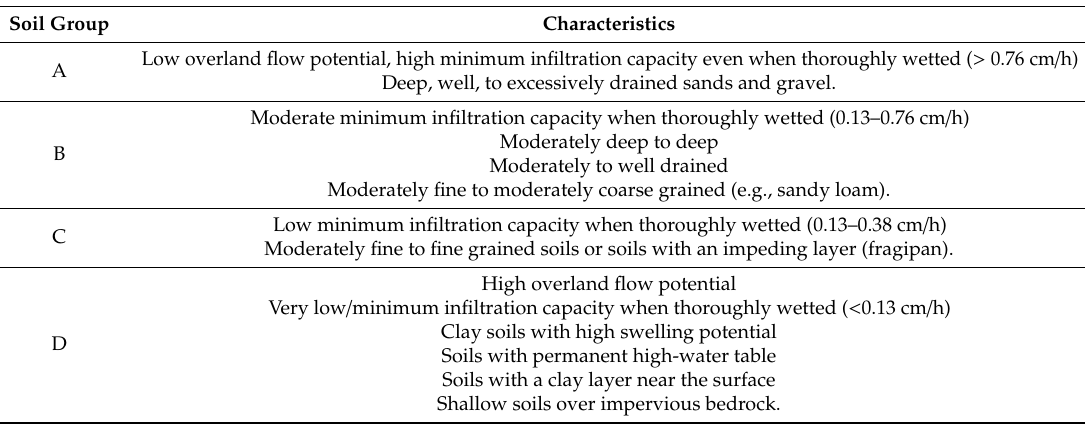
Table 3. Classification of hydrologic soil groups.